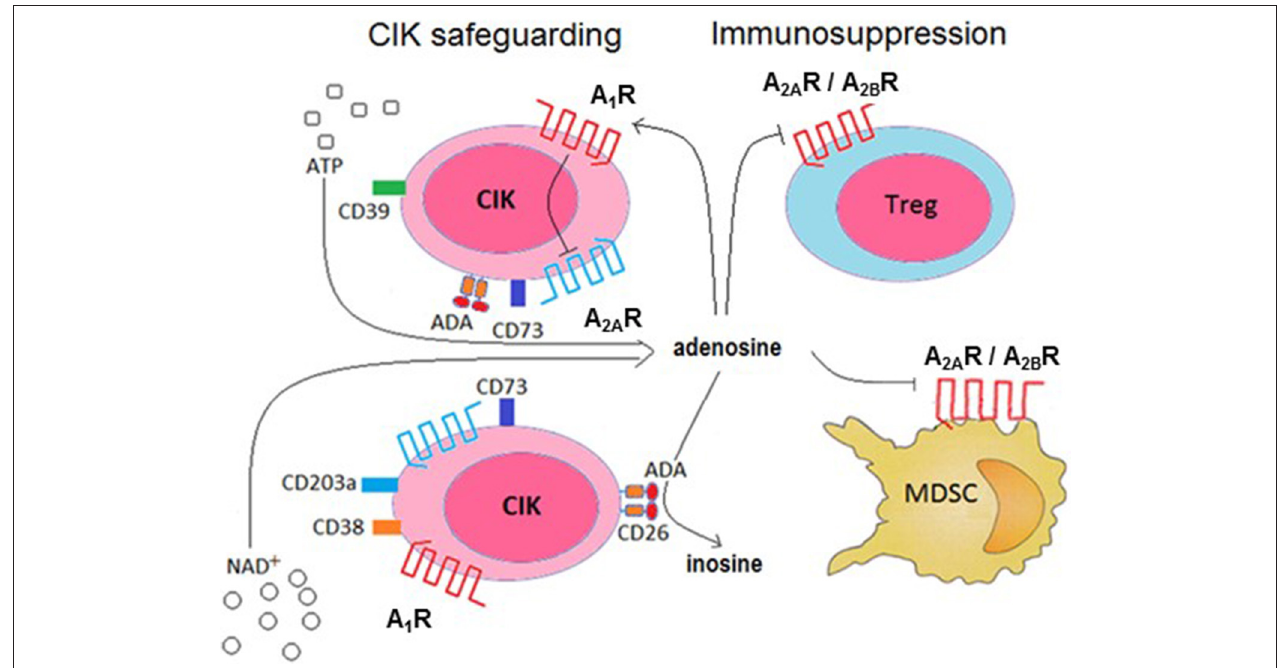
FIGURE 8 | Conceptual model of the role of ADO production, metabolism and receptor ligation in the cytotoxic activity of CIK cells. CIK cells prevent the induction of an autocrine immunosuppression by abrogating A 2A R-mediated signaling (by A 1 R activation) and deamination of ADO catalyzed by the CD26/ADA complex. In turn, ADO produced by CIK cells can reduce pro-cancer immune responses through paracrine cell inhibition (e.g., Treg, MDSC